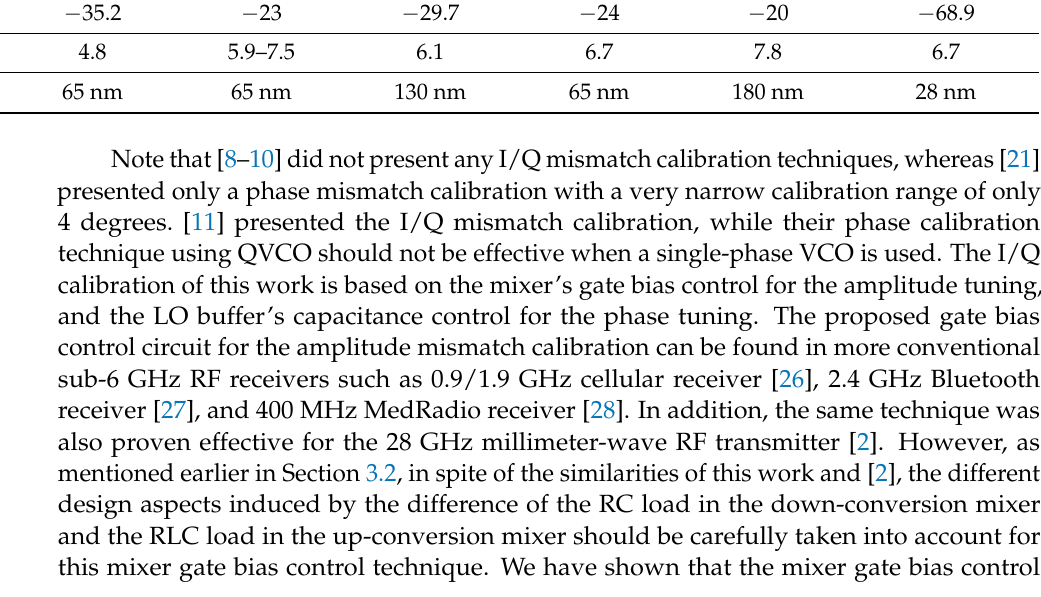
Table 1. Performance summary and comparison.